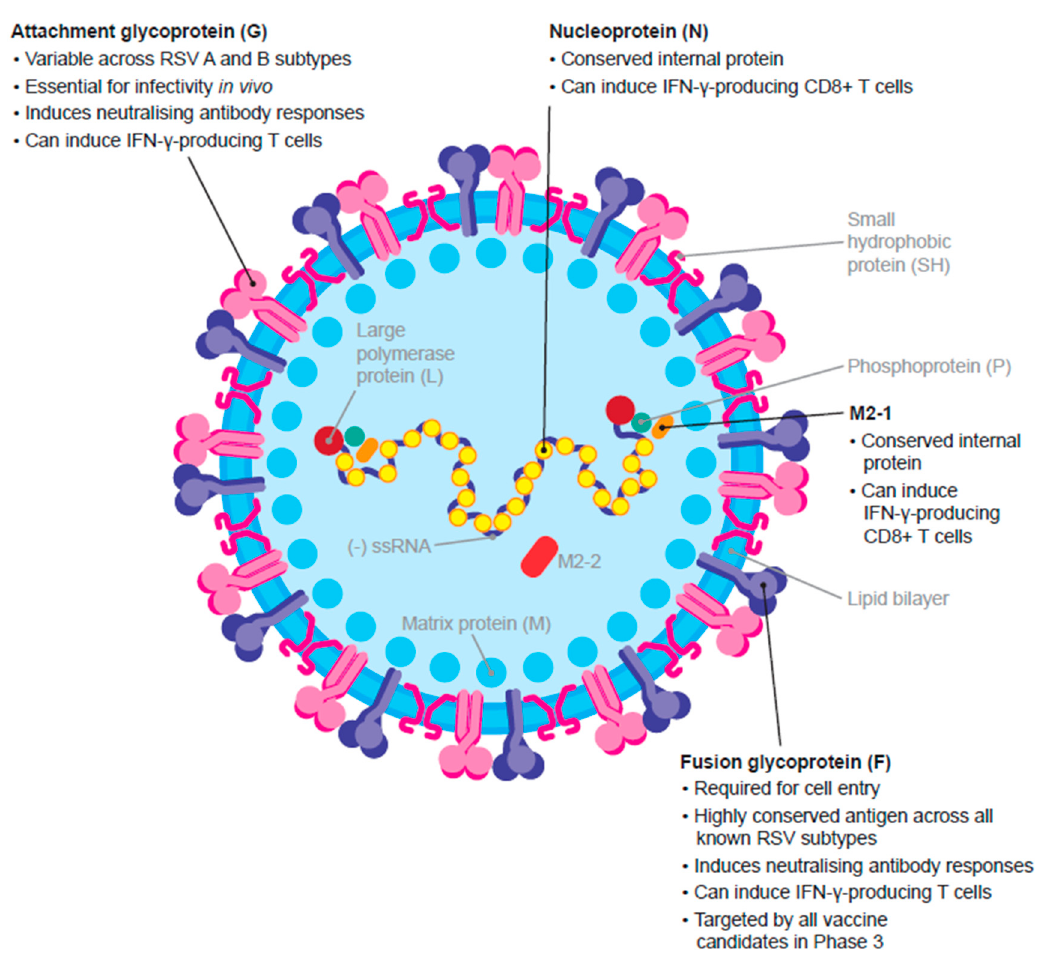
Figure 2. RSV virion structure and antigen targets for the MVA-BNA-RSV vaccine candidate. The vaccine incorporates five different RSV antigens (F, G (A), G (B), M2-1, and N) to stimulate a broad immune response against both RSV subtypes (A and B). IFN- γ , interferon- γ ; RSV, respiratory syncytial virus. Adapted from ref. [18] CC BY 4.0.